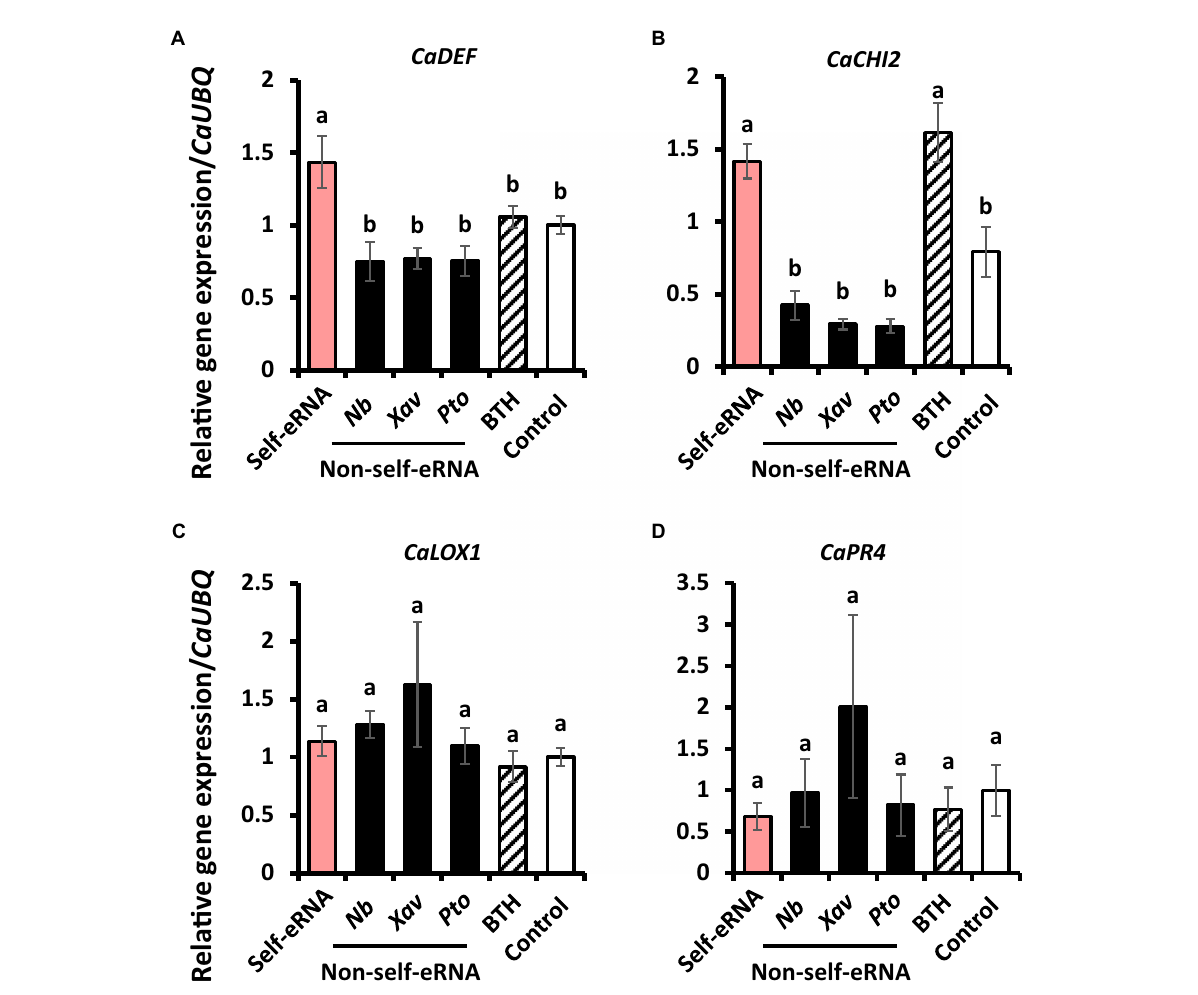
FIGURE 4 Induction of defense-related genes in pepper following self-eRNA treatment under field conditions. Quantifications of the expression of marker genes of the CaDEF (A) , CaCHI2 (B) , CaLOX1 (C) , and CaPR4 (D) . CaDEF related abscisic acid, salicylic acid, and jasmonic acid signaling pathways in plants. CaCHI2 related abscisic acid, ethylene, and jasmonic acid signaling pathways in plants. CaLOX1 related salicylic acid and ethylene signaling pathways in plants. CaPR4 related jasmonic acid signaling pathway in plants. Plants treated with self-eRNA and non-self-eRNA that including N. benthamiana ( Nb ), X. axonopodis pv. vesicatoria ( Xav ), and P. syringae pv. tomato ( Pto ), 1 mM BTH, and control. CaUBQ was used as a housekeeping gene for data normalization. Data represent mean ± SEM. Different letters indicate statistically significant differences between control and other treatments ( p = 0.05; LSD